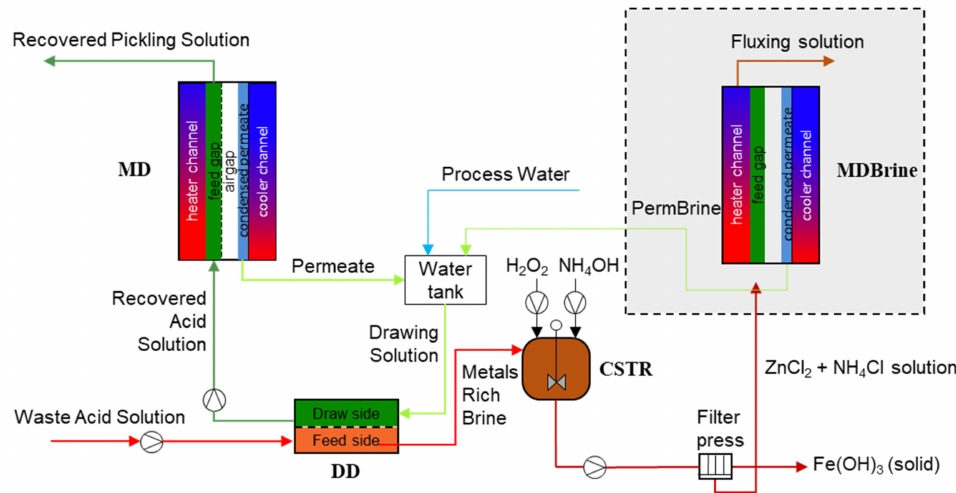
Figure 7. Schematic representation of the main units of the integrated process with additional MD brine